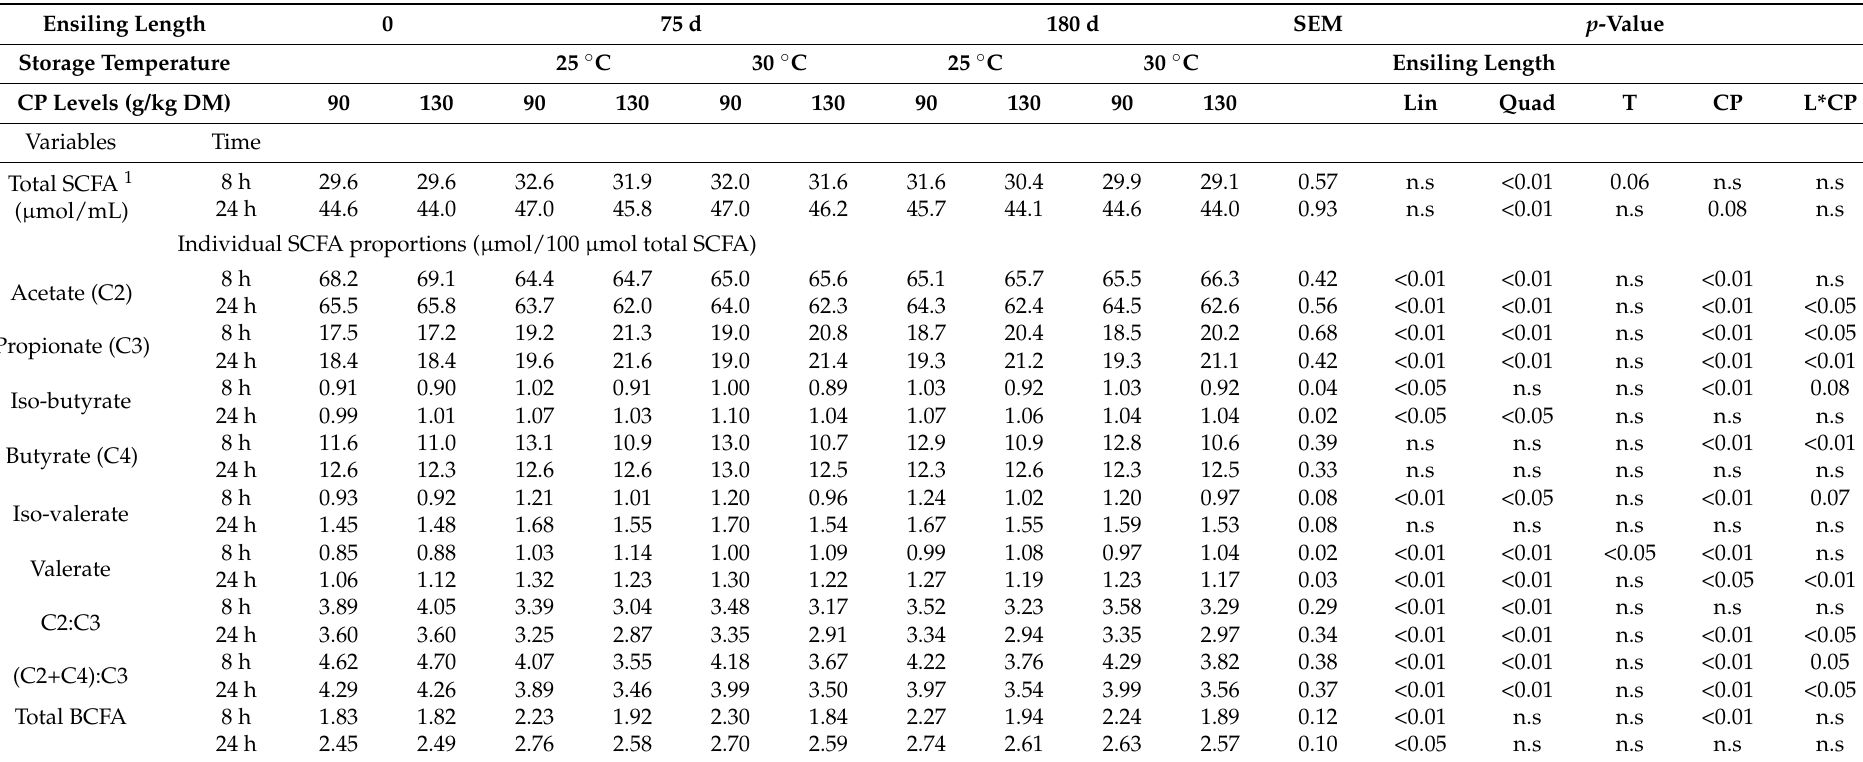
Table 4. Effect of ensiling length (L), storage temperature (T), and crude protein (CP) level on the in vitro fermentation of short-chain fatty acid (SCFA) concentration and individual SCFA proportions at different incubation periods (least squares means; n =